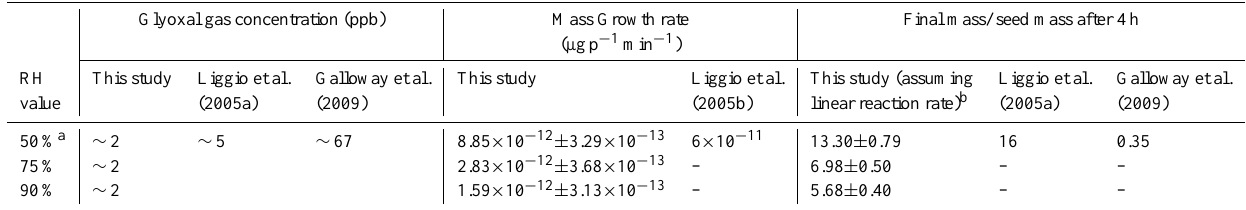
a RH values for Liggio et al. (2005a, b) are 49% and seed aerosol size of 127.8nm and for Galloway et al. (2009) the RH is 55%. b Based on the findings of Liggio et al. (2005a, b) that the reaction rate is linear in the first 4h of their measurements.